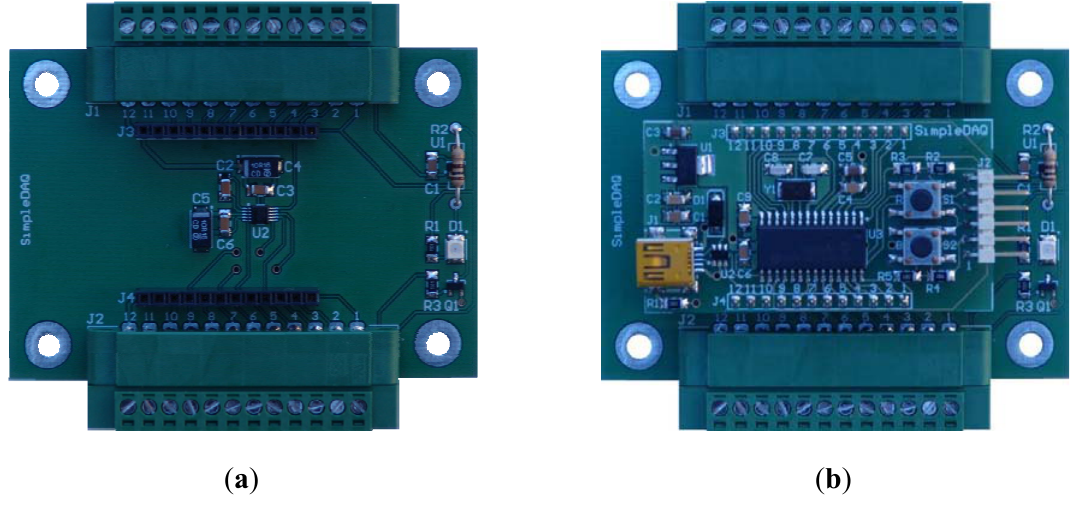
Table 6 . Key components of an application board.